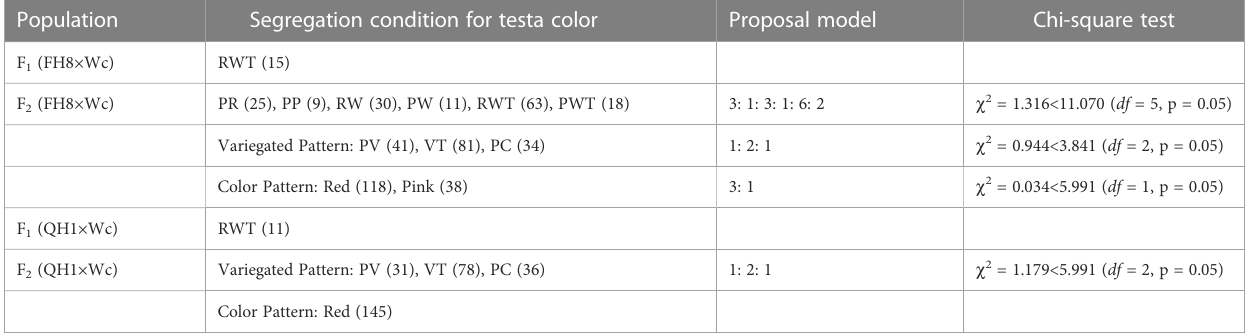
TABLE 1 Genetic analysis of variegated testa color. Population Segregation condition for testa color Proposal model Chi-square